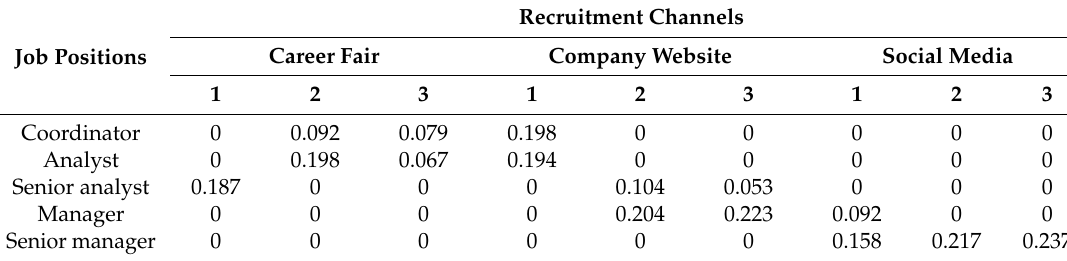
in three time periods. ij